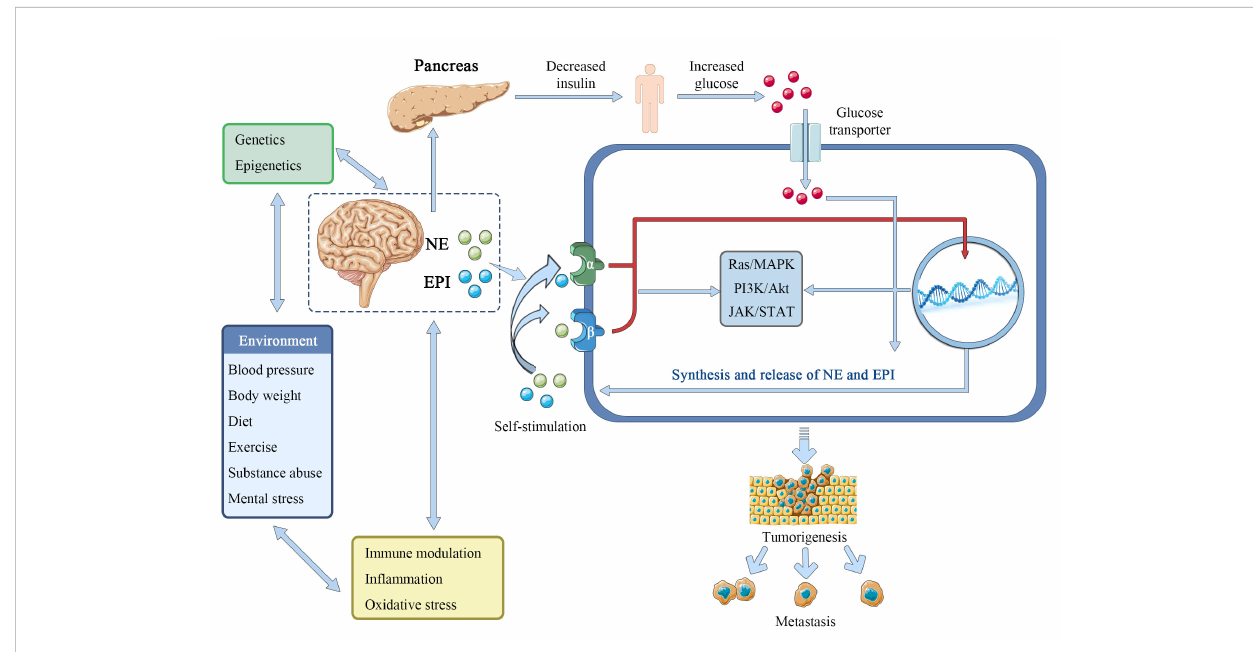
FIGURE 4 Epinephrine and norepinephrine contribute to